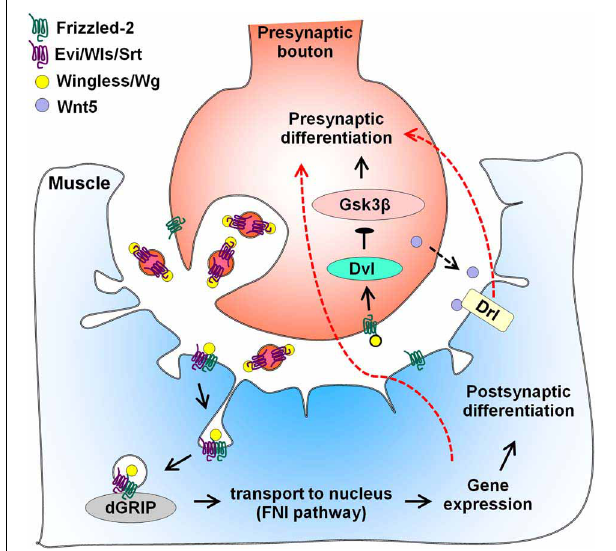
FIGURE 2 | Wnt regulation of larval NMJ differentiation. Vesicular release of the Wnt-binding protein Evenness Interrupted/Wntless/Sprinter (Evi/Wls/Srt) facilitates pre-synaptic secretion of Wingless/Wg. In the pre-synaptic bouton, binding of Wg to the Frizzled-2 receptor (DFz2) activates components of the canonical pathway and leads to pre-synaptic differentiation. In the post-synaptic muscle, Wg binds to DFz2, inducing endocytosis of the receptor. As part of the Frizzled nuclear import (FNI) pathway, Evi/Wls/Srt recruits the Wg receptor-interacting protein dGRIP, leading to transport of DFz2 to the nucleus. Entry of DFz2 into the nucleus alters gene expression, promoting post-synaptic, and possibly, pre-synaptic differentiation (red dotted arrow). Additional regulators of Wg signaling excluded from this figure include laminin A, integrin, the HSPG perlecan/trol and HSPG sulfation. In addition, Wnt5 is also secreted by the pre-synaptic bouton (black dotted arrow) and acts through the tyrosine kinase-like receptor Derailed (Drl) to promote pre-synaptic differentiation retrogradely (red dotted